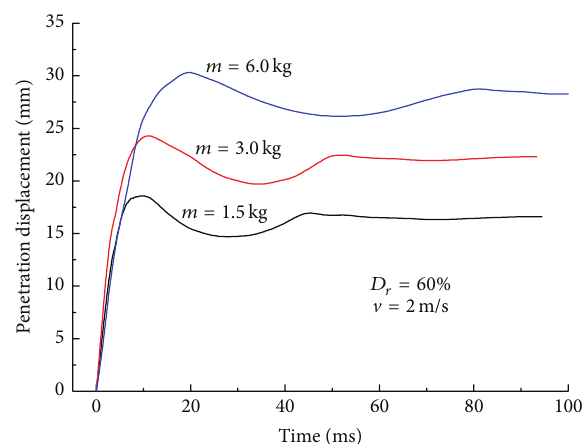
Figure 14: Time-history curves of penetration displacement with 𝐷 𝑟 = 60 %, V = 2 m/s.